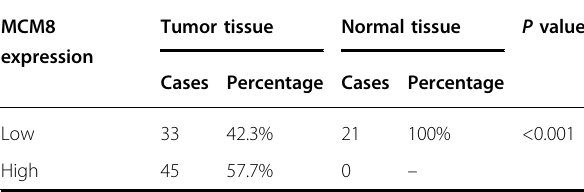
Table 1 Expression patterns of MCM8 in osteosarcoma tissues and paracarcinoma tissues revealed in immunohistochemistry analysis.